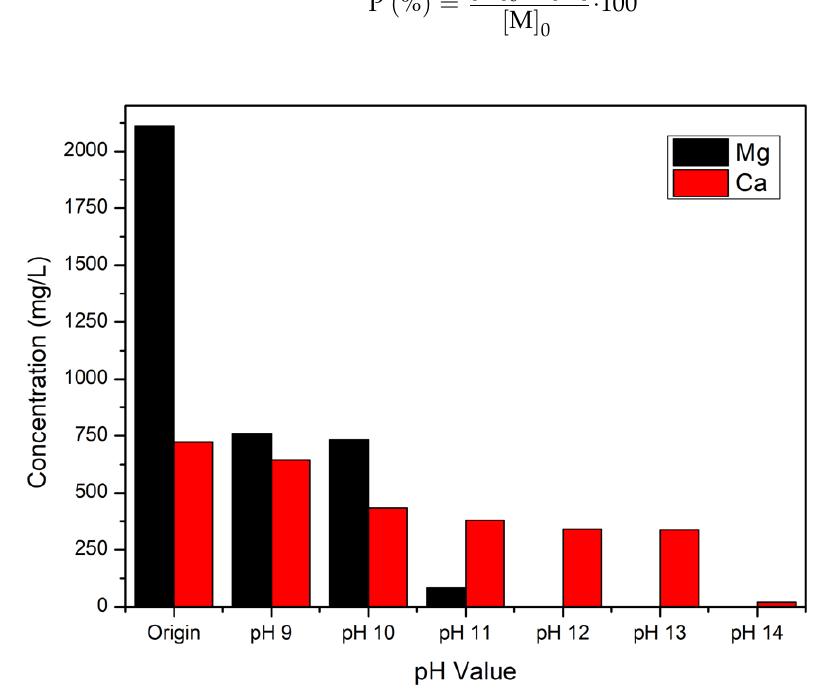
Figure 3. Precipitation efficiencies of magnesium hydroxide and calcium hydroxide.